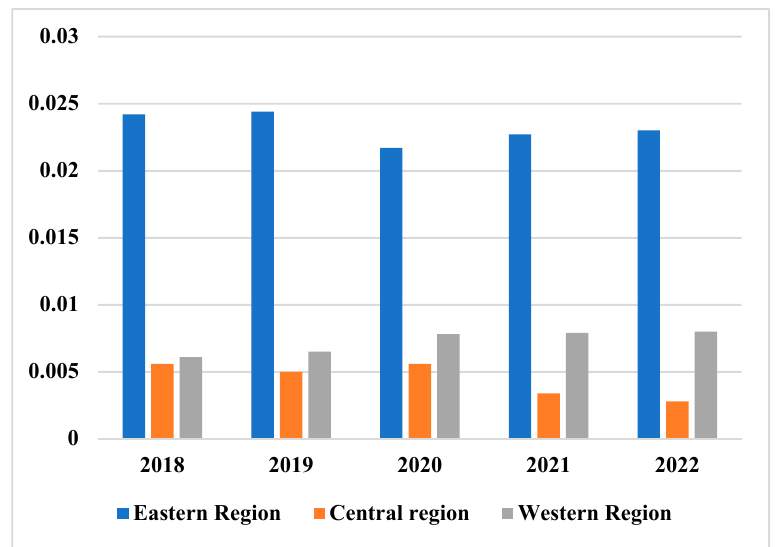
Figure 3. Change value of public health Theil index of fiscal expenditure in eastern, central and western regions. Table 7. Changes of Theil index of public health in eastern, central and western regions. Intra Group Theil